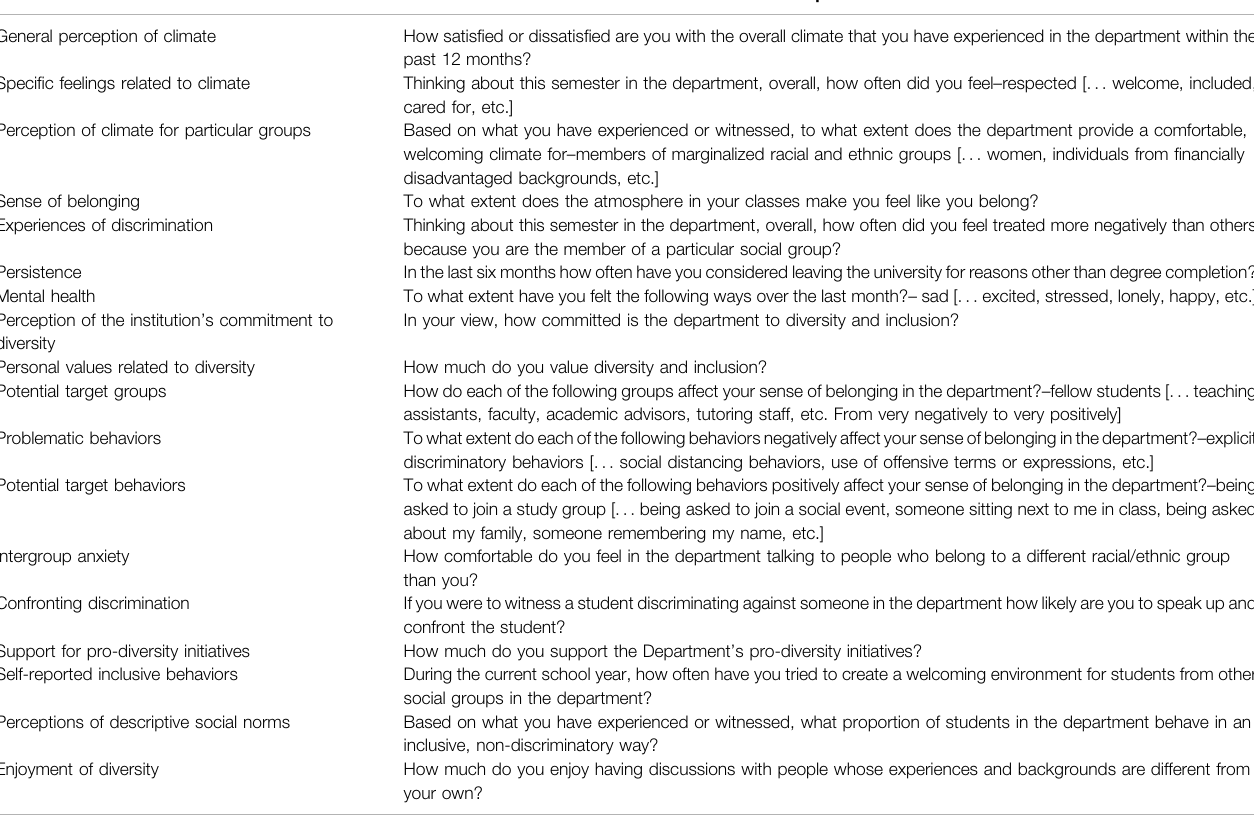
TABLE 1 | List of constructs that are frequently measured in climate surveys.